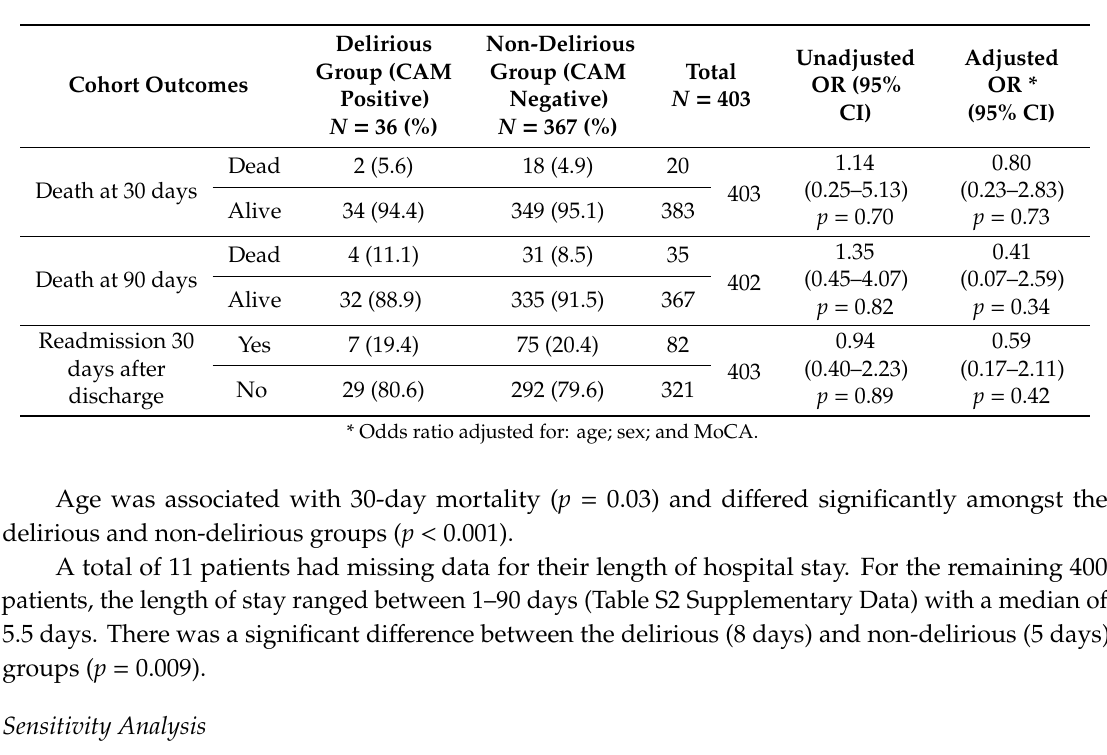
Table 3. Odds ratios to measure the association between delirium and